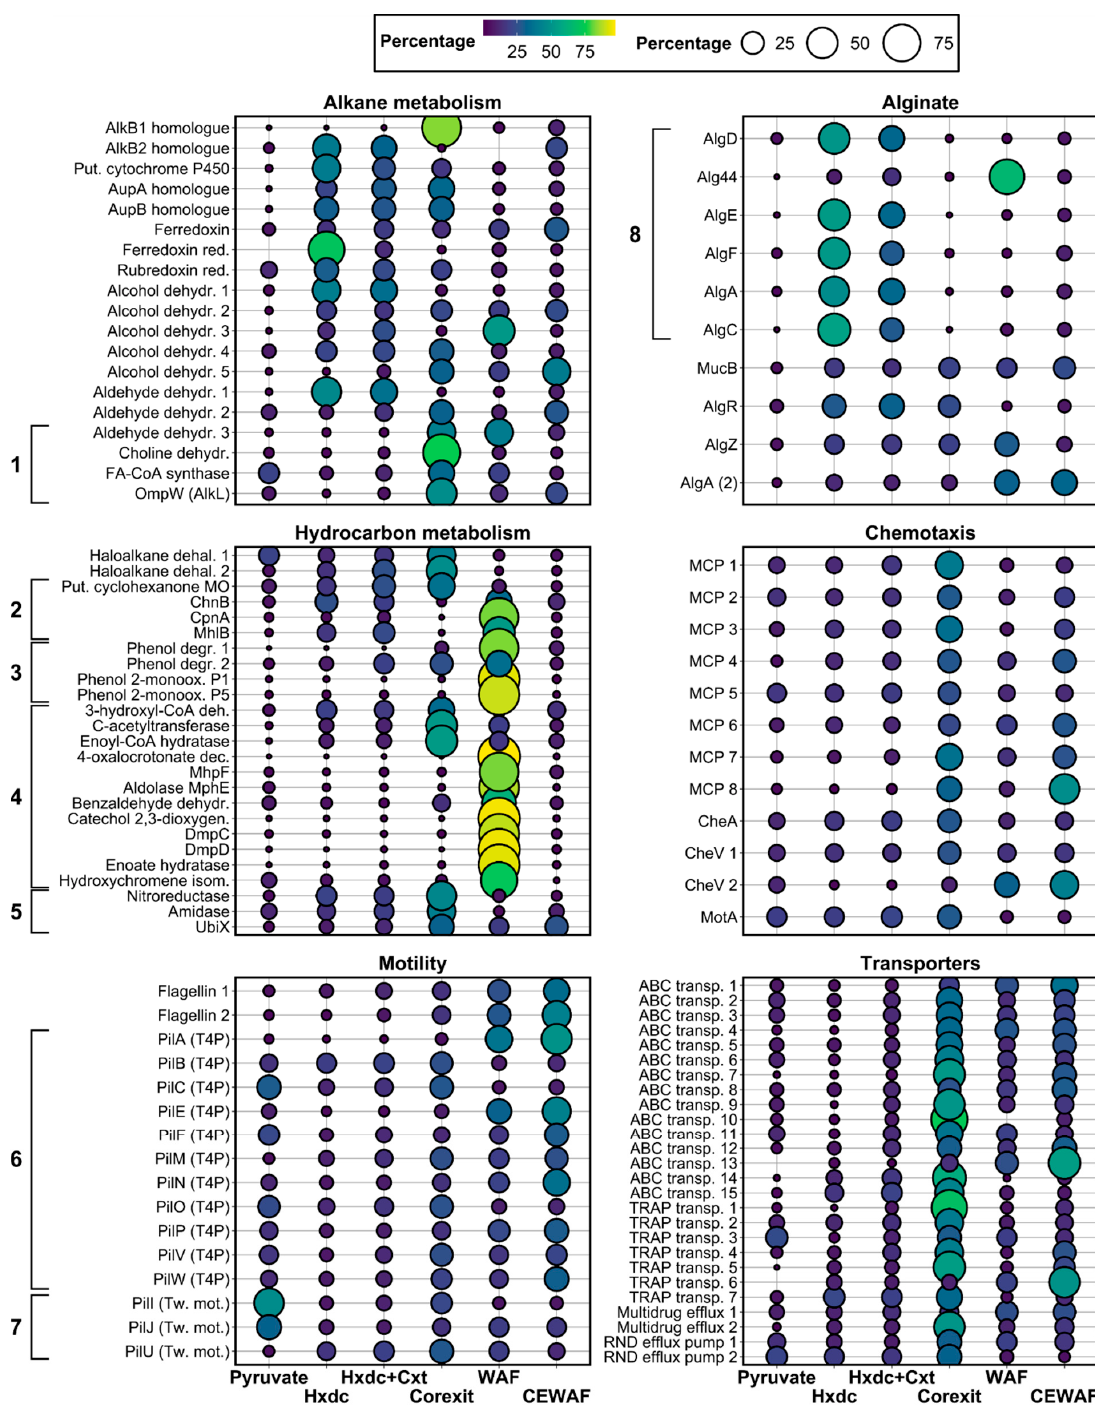
Figure 2. Normalized, relative mean abundances (symbolized by circle size and color; sum per protein = 100%) of a selection of significantly ( q -value < 0.05) differentially abundant proteins associated with alkane metabolism, alginate synthesis, non-alkane hydrocarbon (HC) metabolism, chemotaxis, motility, and transmembrane transport systems during growth of Marinobacter sp. TT1 cultures on different carbon sources. Treatments received either pyruvate, n- hexadecane (Hxdc), n- hexadecane and Corexit (Hxdc+Cxt), only Corexit (Corexit), crude oil WAF, or chemically enhanced WAF (CEWAF). 1 = proteins belonging to the proposed alk operon (plus AlkB1 homologue); 2 = Cycloaliphatic HC metabolism; 3 = Phenol metabolism; 4 = Aromatic HC metabolism; 5 = Aminobenzoate metabolism; 6 = Type IV pilus assembly; 7 = Twitching motility; 8 = Proteins belonging to the proposed alg operon. See Table S9 for protein names.